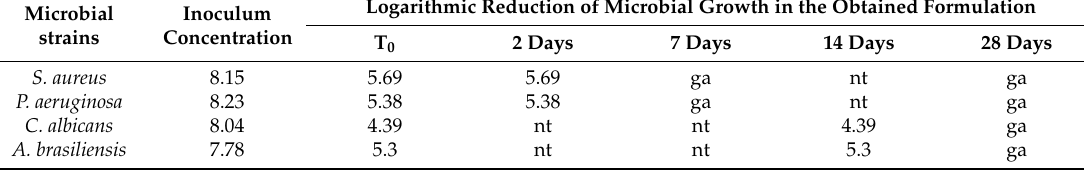
Table 3. Challenge test results.